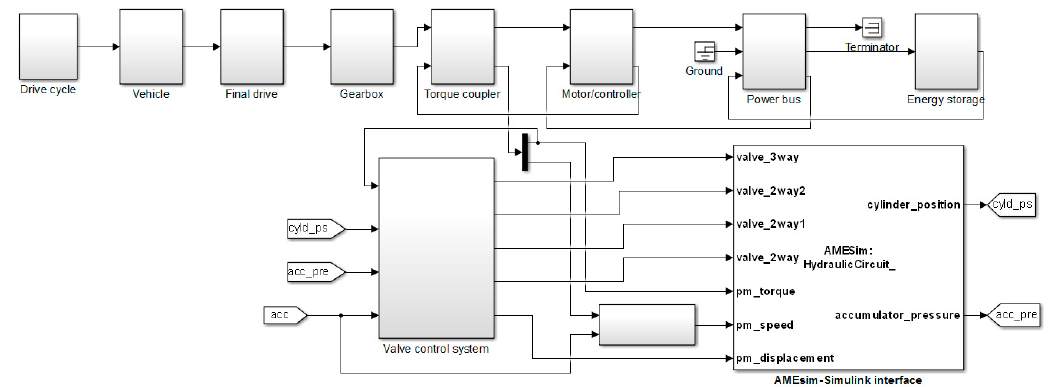
Figure 8. Vehicle components and control system model on Simulink.